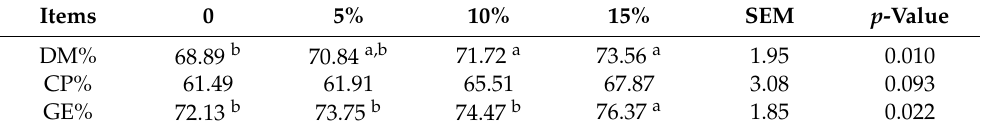
Table 4. Effects of FPFF on tract apparent digestibility of DM, CP, and GE (19–21 days).